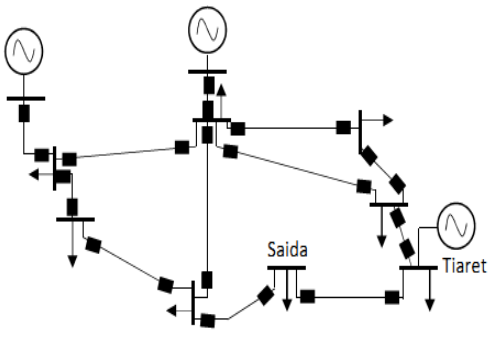
Fig. 1: Study network, the west Algerian network.